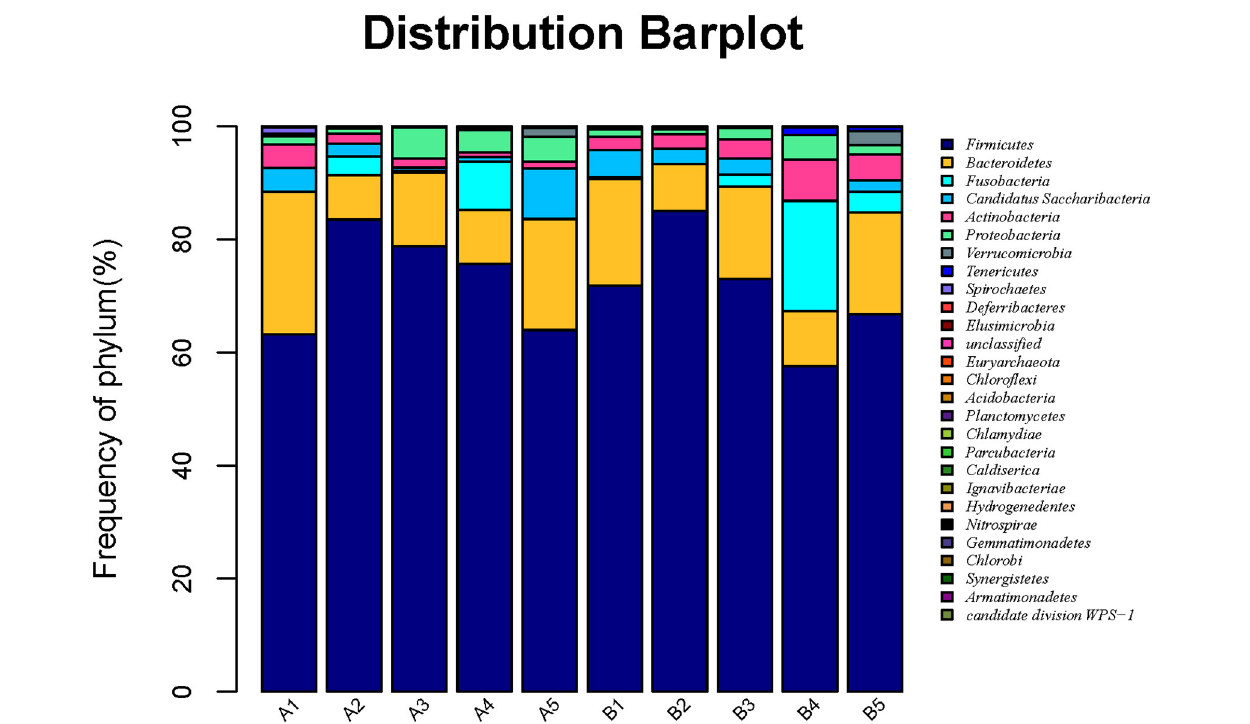
FIGURE 4 | Horizontal abundance of intestinal microflora communities in mice at the phylum level. Clustering was conducted according to the abundance of OTUs, and different colors were used to represent high- and low-abundance microbial species to annotate OTUs to species.